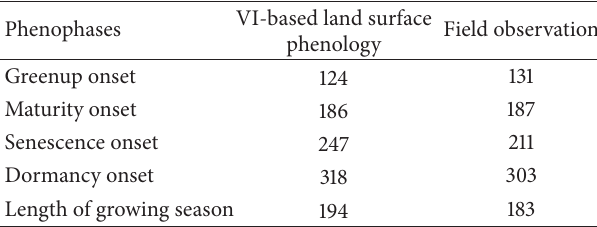
In situ phenology observations are collected from Chen and Li